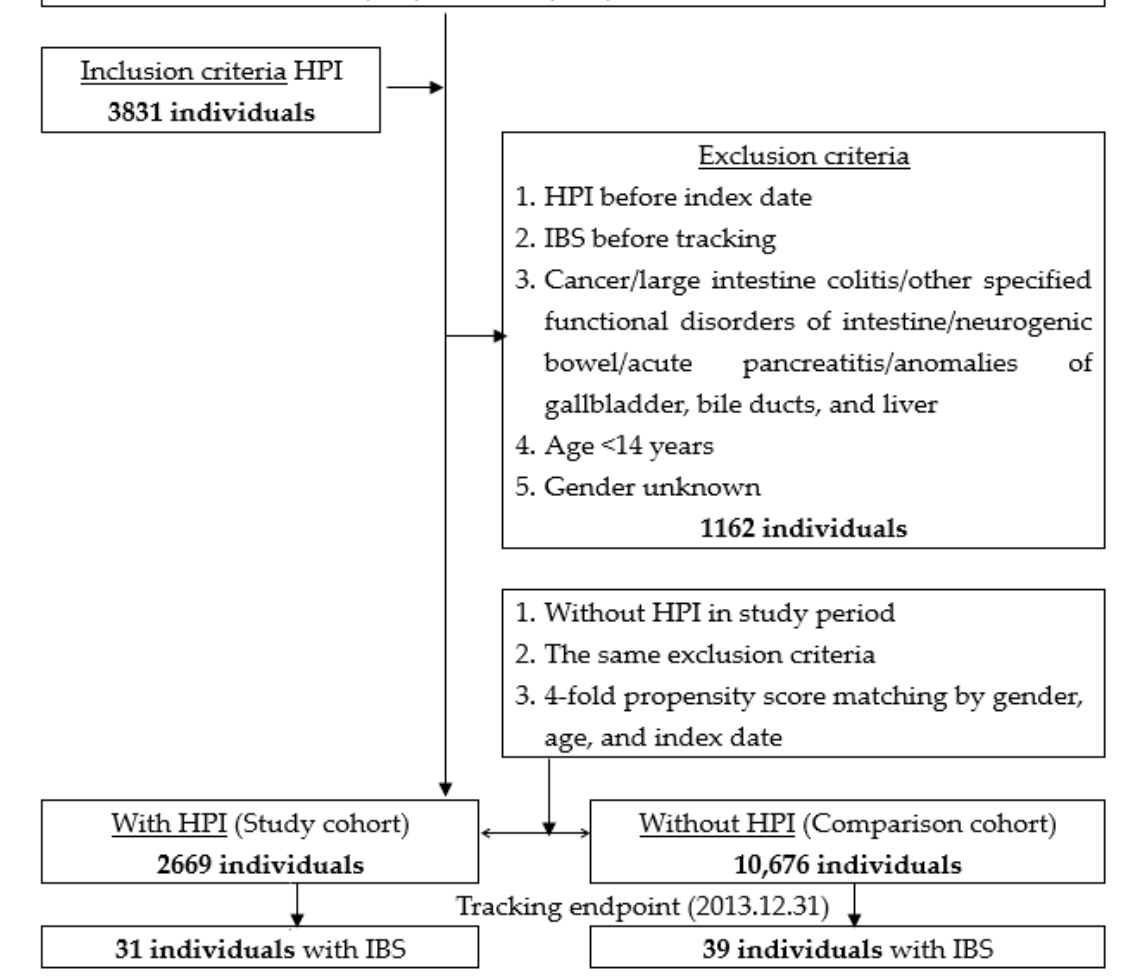
Figure 1. The flowchart of the study sample selection from the National Health Insurance Research Database in Taiwan. HPI: Helicobacter pylori infection.